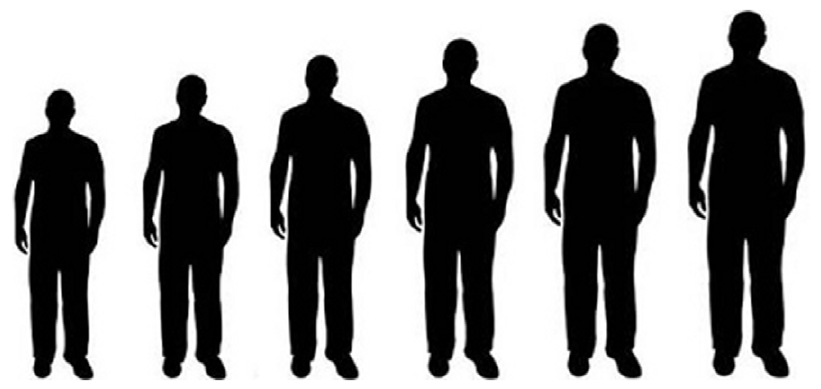
Figure 1. Array used by participants to provide estimates of size of target individual.